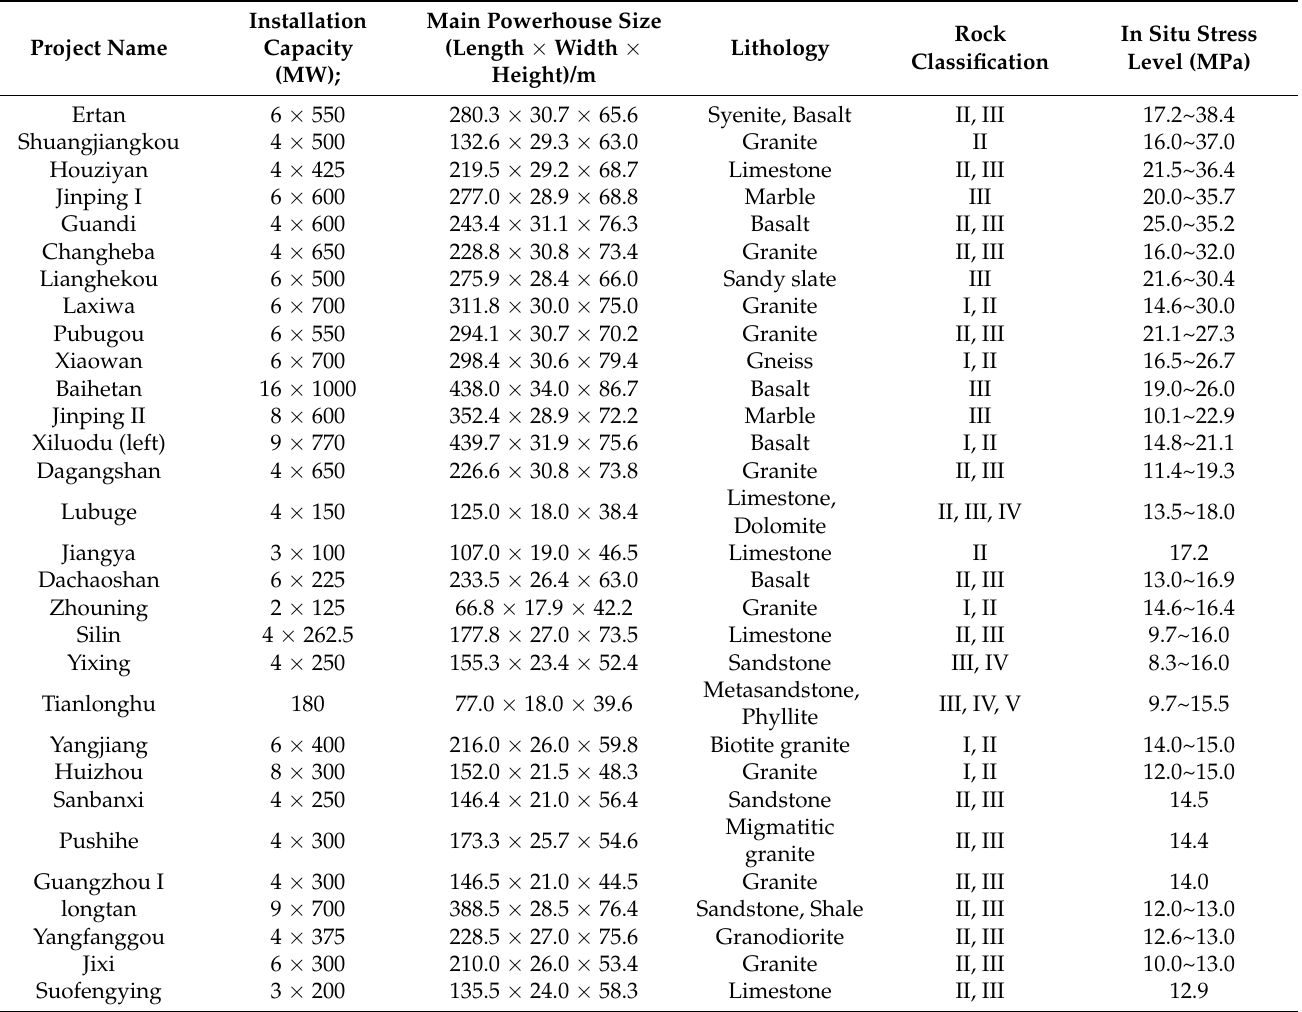
Figure 5. Distribution of underground powerhouses in China. To perform research into the underground powerhouses in China, fifty-one of them are collected and listed in order of in situ stress levels to introduce the stress environment and other characteristics, as shown in Table 1.